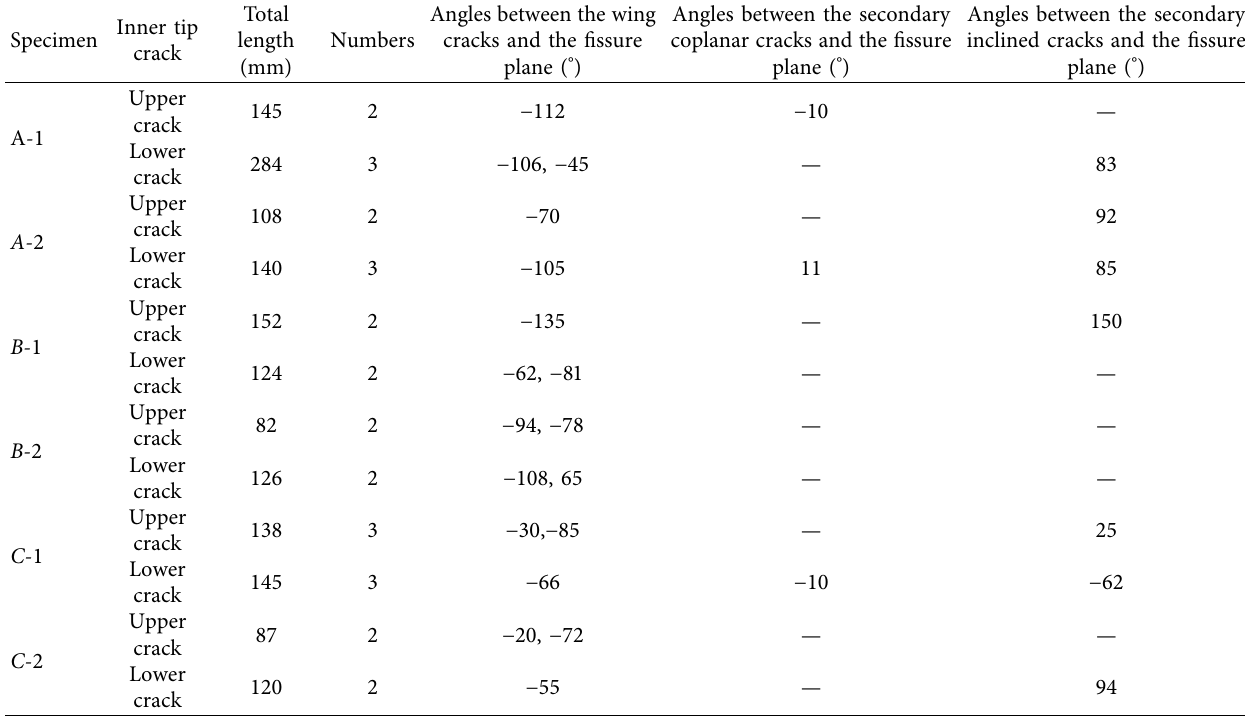
Table 3: The numbers, lengths, and positions of the major